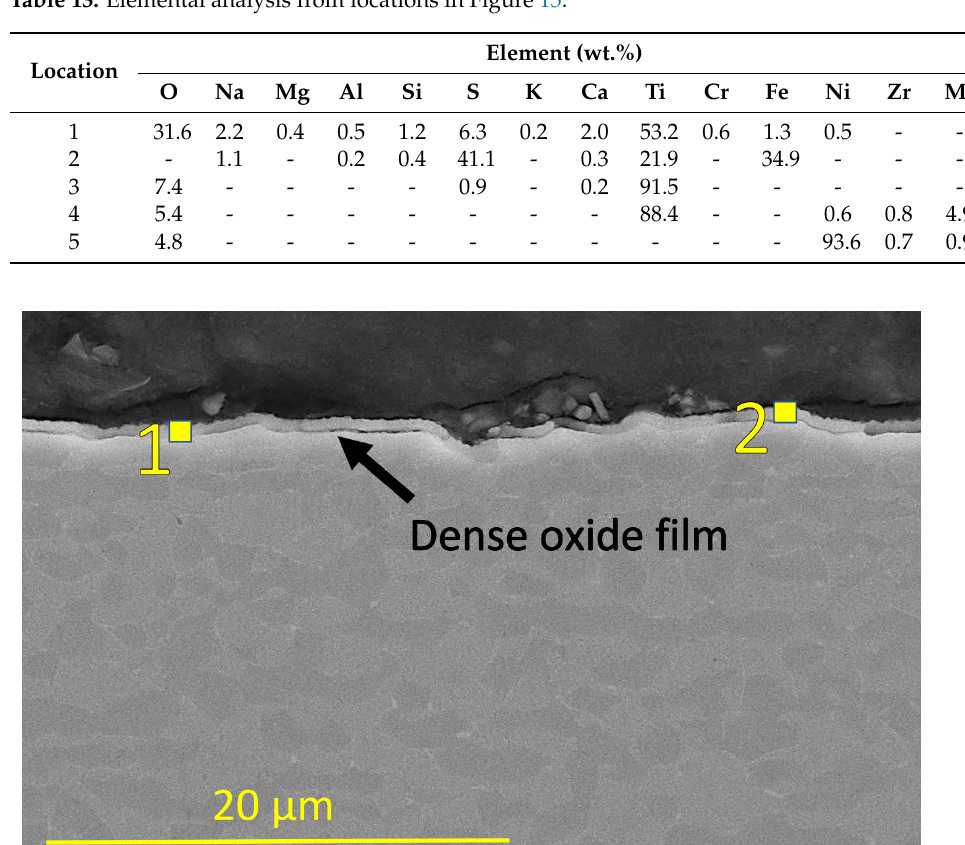
Figure 16. SEM image and XEDS analysis of a cross-section of the middle part of the tested tita- nium alloy sample 5 in the middle of the second reactor (superheated fluid).